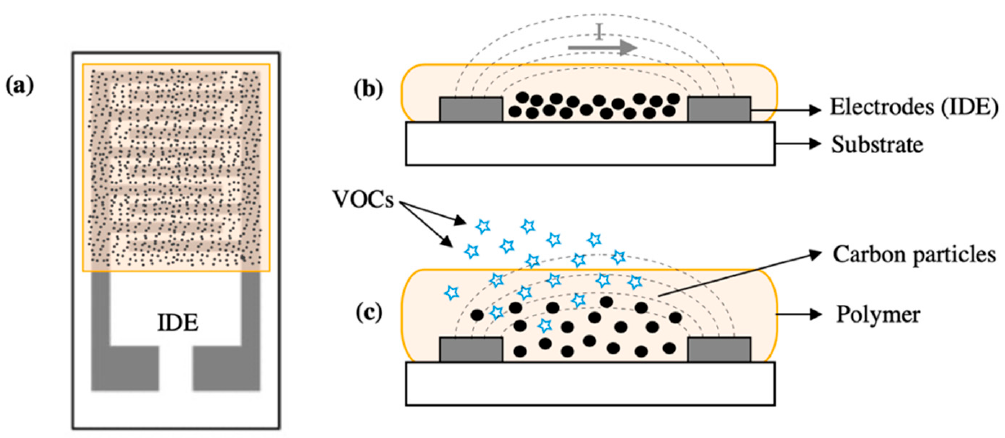
Figure 7. Working principle of an IDE-based gas sensor with a hybrid polymer composite: ( a ) top view of the gas sensor and the active layer; ( b ) representation of the polymer matrix with carbon fillers and its electrical characteristics prior to detection; and ( c ) polymer swell-effect due to the adsorption of VOCs, altering the distribution of fillers and overall impedance/conductivity of the composite [134].